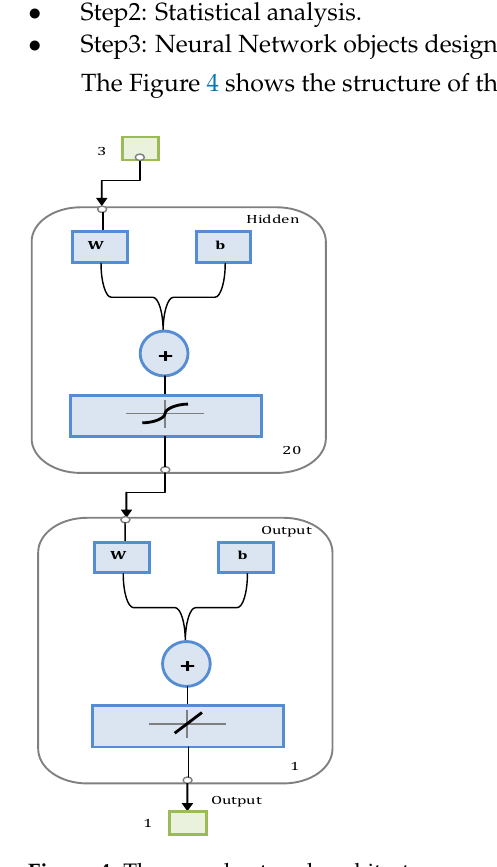
Figure 4. The neural network architecture.